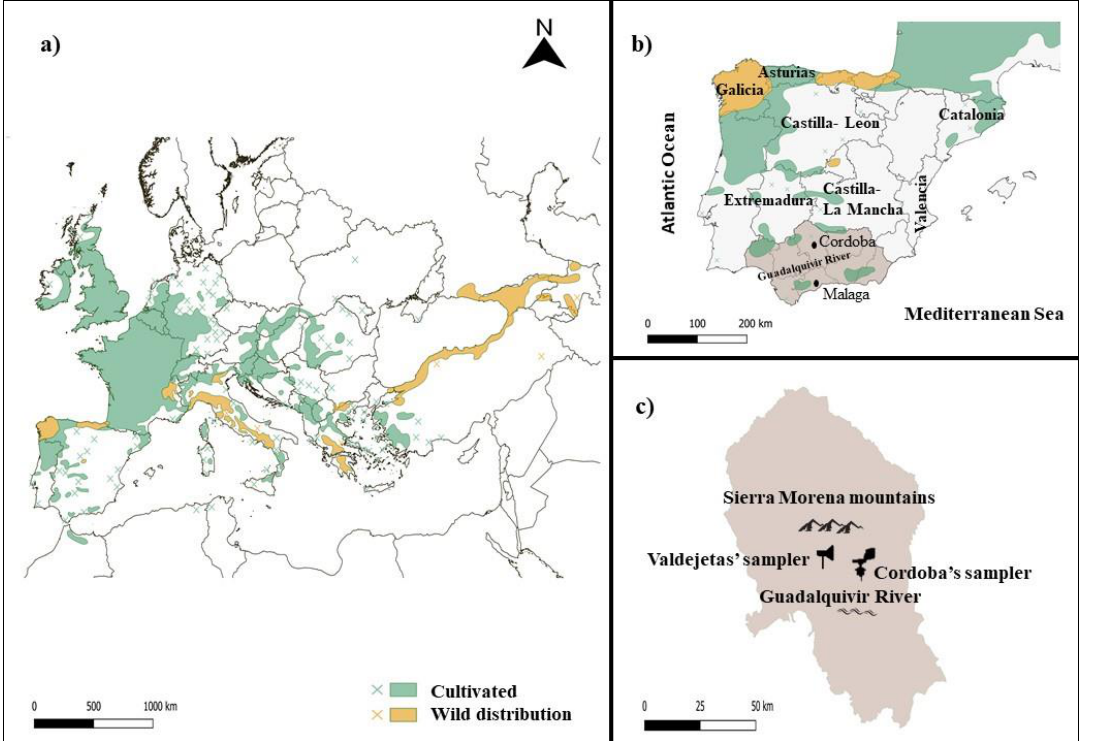
Figure 1. Study area: ( a ) distribution map of Castanea sativa in Europe and north Africa based on the distribution layers proposed by Caudullo et al. [3]. ( b ) Chestnut population in Spain and in the Andalusia region (darker marked area). ( c ) Location of samplers in Cordoba province.